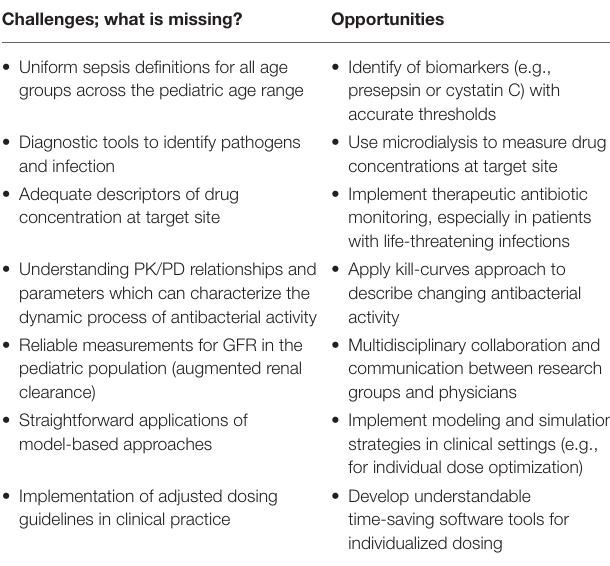
TABLE 2 | Challenges to overcome the burden of sepsis and the opportunities to improve diagnostic tools, measurement techniques and implementation of modeling and simulation